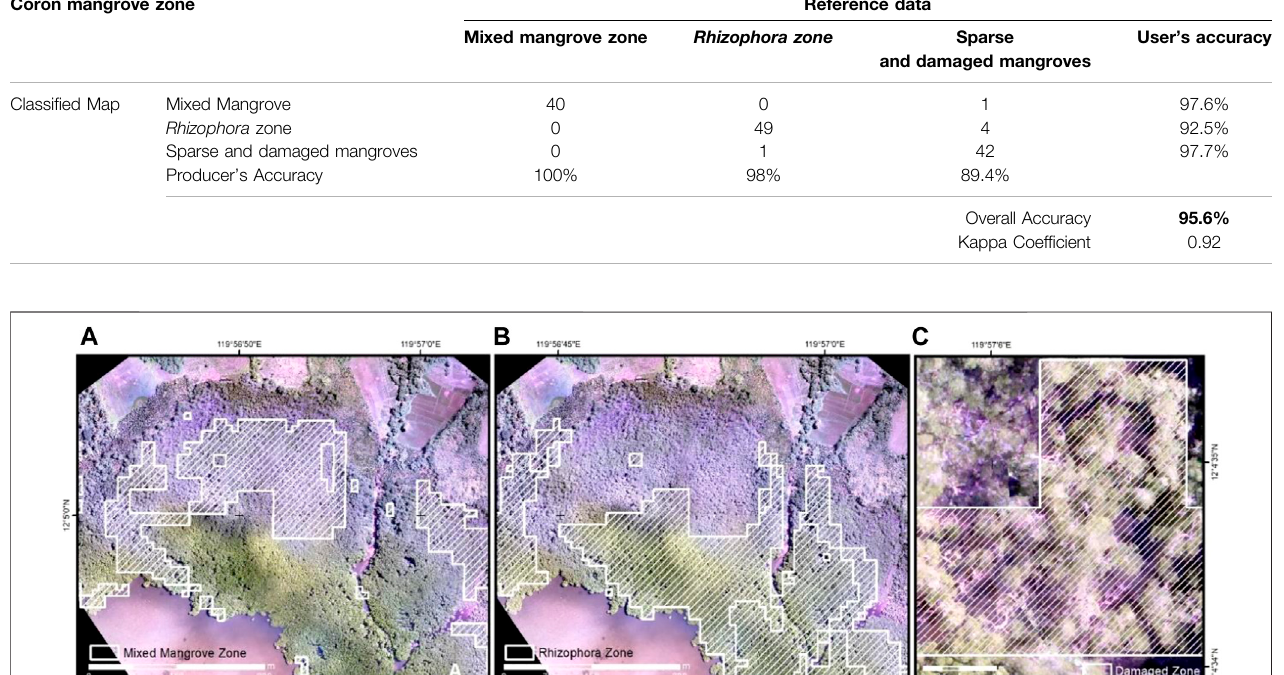
Frontiers in Remote Sensing |